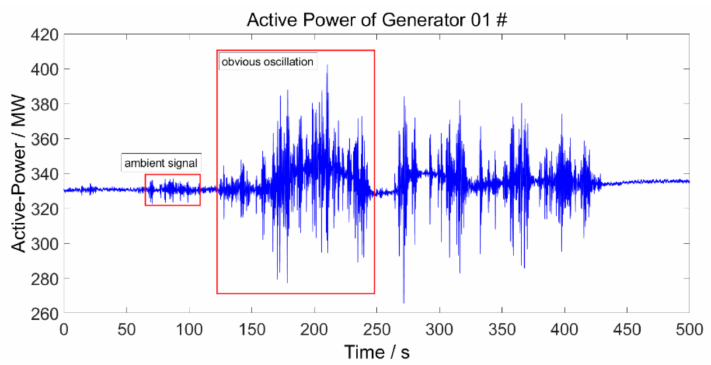
Figure 5. The actual oscillation signal